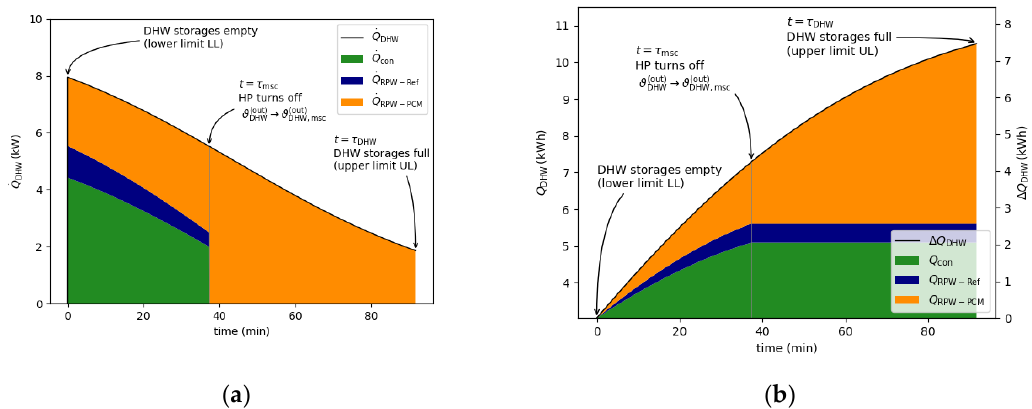
Figure A2. ( a ) Calculated heat transfer rate to the decentralized DHW storages during the energy efficient DHW charging operating mode (c) for a storage at the lower charging limit in standard operating mode at t = 0. The heat transfer rate consists of contributions from the refrigerant via the condenser (green) and the RPW-HEX (blue) and of the contribution from the PCM and the aluminum in the RPW-HEX (orange). ( b ) shows the calculated total amount of energy transferred to the DHW storages during the charging process.